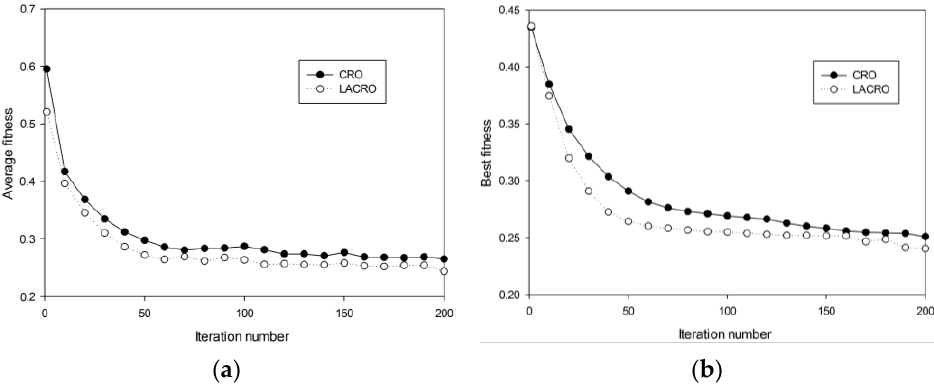
Figure 5. ( a ) Average fitness in various generations; ( b ) Best fitness in various